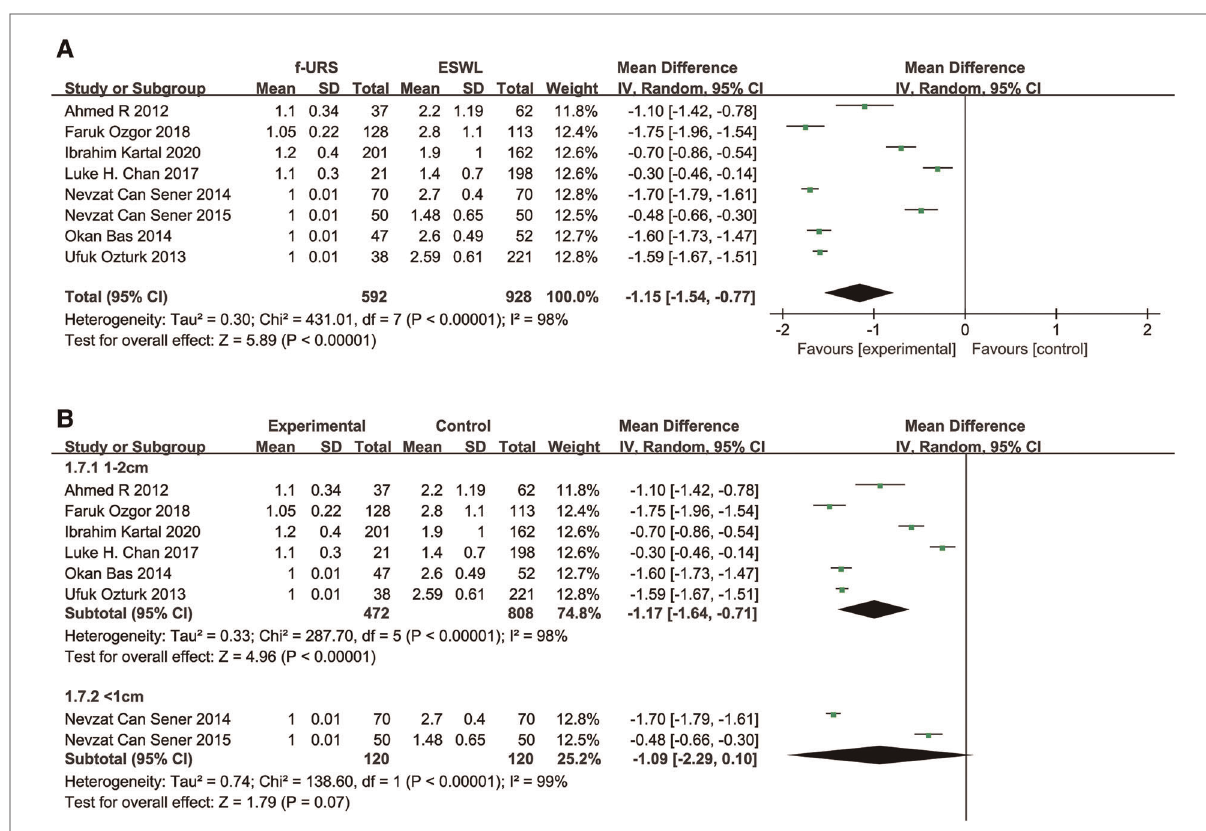
FIGURE 10 Forest plot and meta-analysis of the number of sessions for ( A ) all studies and ( B ) subgroups of stone length 1 – 2 cm and <1 cm for f-URS and